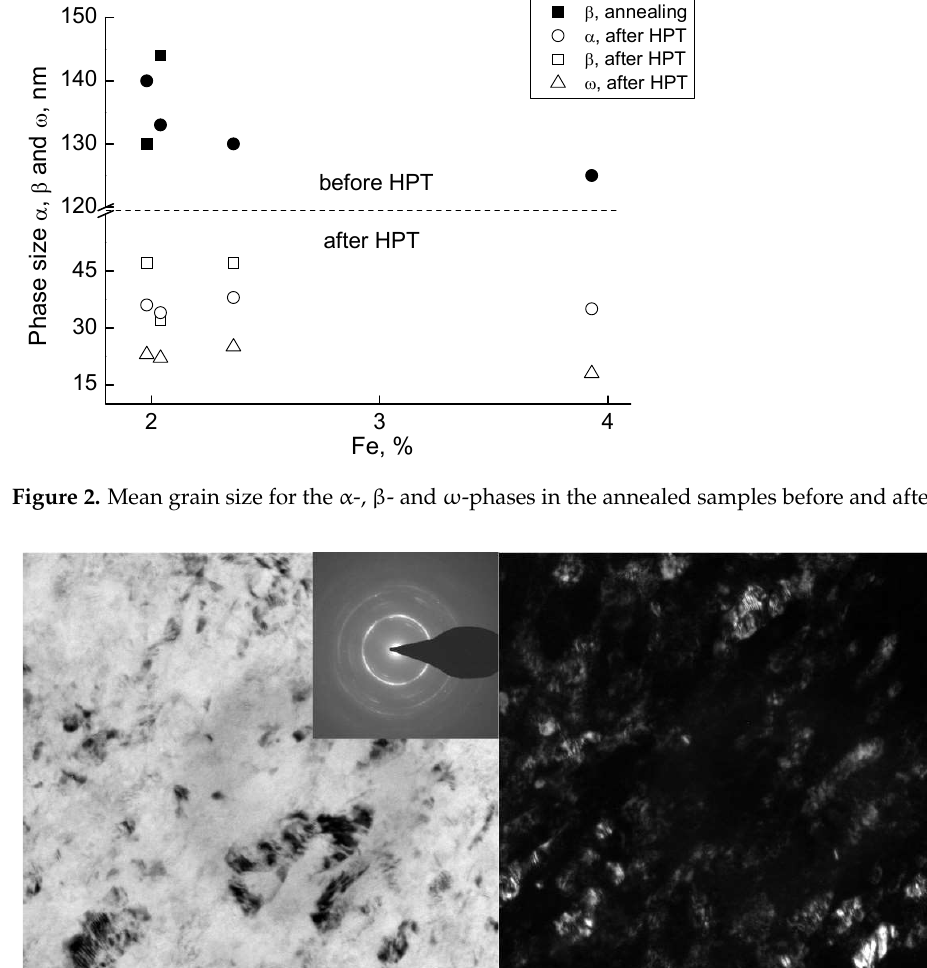
area electron diffraction (SAED) pattern is shown as inset. It contains the rings of α - and ω -phases. Figure 2. Mean grain size for the α-, β- and ω-phases in the annealed samples before and after HPT. Table 2. Lattice parameters, phases and their volume fraction in alloys after heat treatment and HPT. Iron Con- tent, wt.%